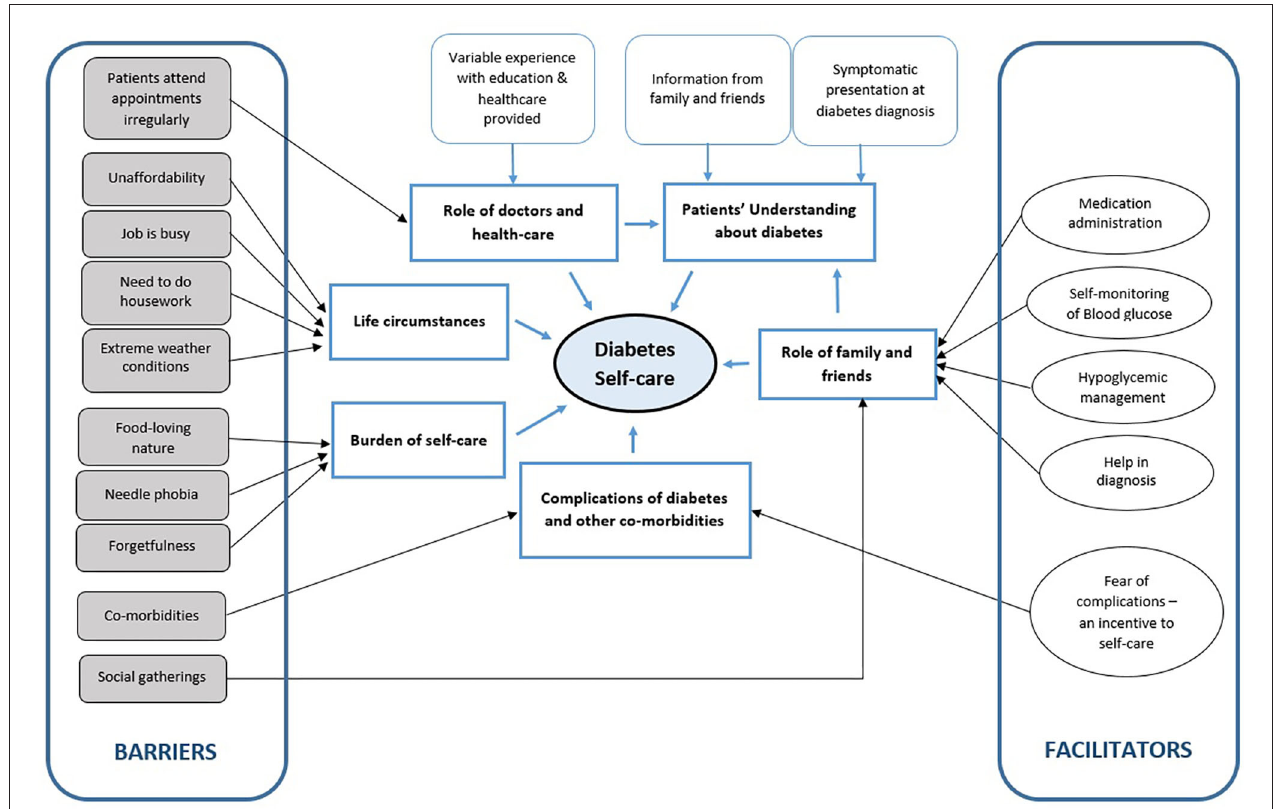
FIGURE 1 | Thematic presentation of factors influencing self care in